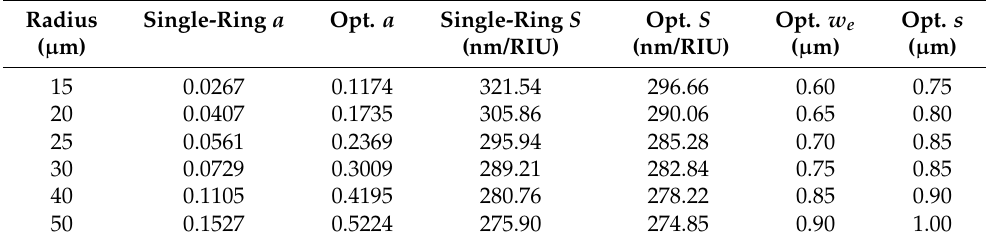
Figure 11. Round-trip field amplitude factor of the principal TM mode for six different values of R : 15 µ m, 20 µ m, 25 µ m, 30 µ m, 40 µ m and 50 µ m at λ = 1550 nm, as a function of the design parameters w e and s . The positions corresponding to the maximal values of a are marked with black spots. Table 2. Single-ring round-trip transmission amplitude factor a and sensitivity S and the corre- sponding values for optimal (Opt.) asymmetric concentric ring geometries for six values of R . The parameters defining the optimized structures, w e and s , are also shown in the table. Results are for the TM-polarized